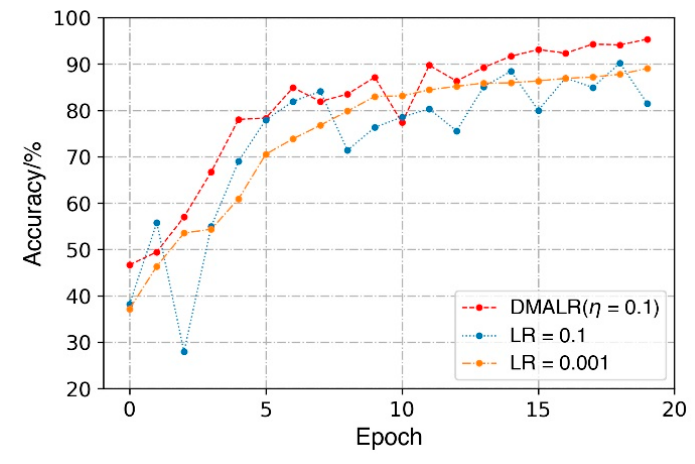
Figure 9. Comparison of training effects in fold 1.